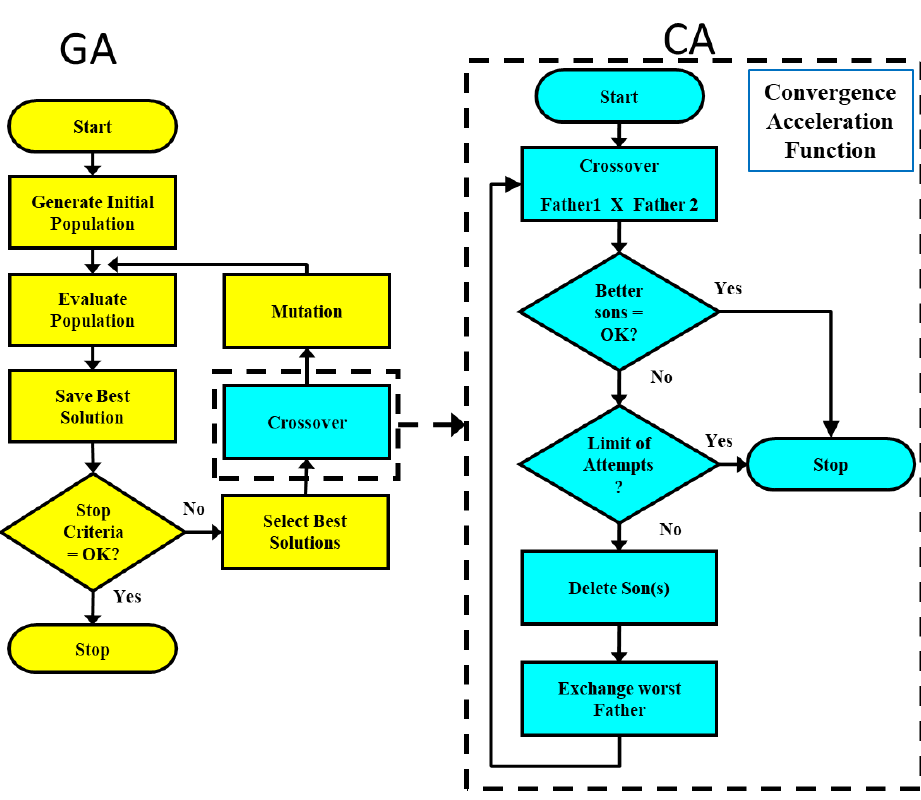
Figure 2. Flowchart of a Genetic Algorithm with the convergence acceleration mechanism. Table 4. Setup parameters of SAGAC